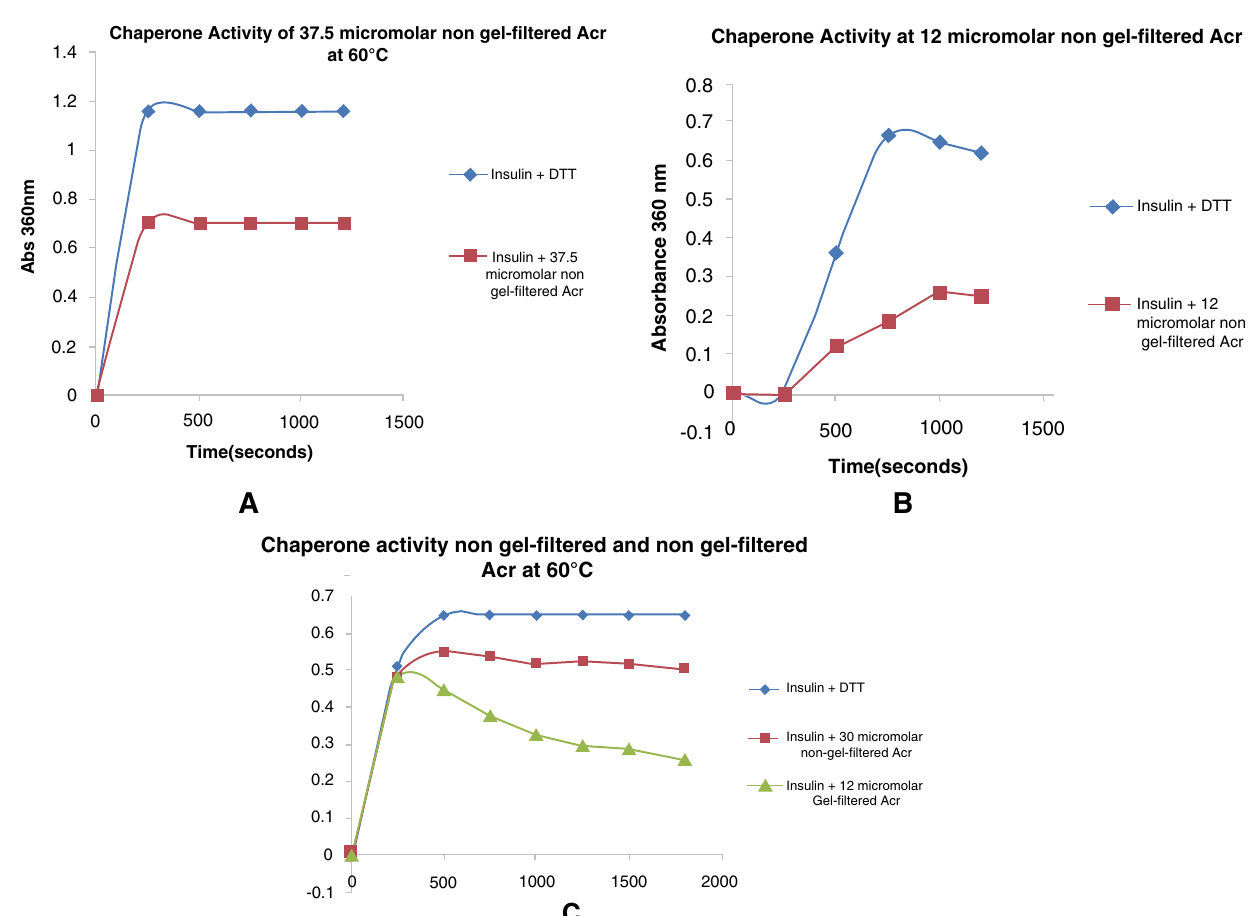
Figure 2. Chaperone Activity of Acr at 60°C. ( a ) Insulin was assayed at a concentration of 125 µM with α -crystallin (Acr) at a concentration of 37.5 µM in an assay volume of 400 µl by adding Acr to prevent DTT induced aggregation of B chain. ( b ) Insulin was assayed at a concentration of 83 µM with Acr added at a concentration of 12 µM in an assay volume of 250 µl. ( c ) Insulin was assayed at a concentration of 118 µM and using two concentrations of non-gel-filtrered Acr (30 µM) and gel-filtered Acr (12 µM), in an assay volume of 250